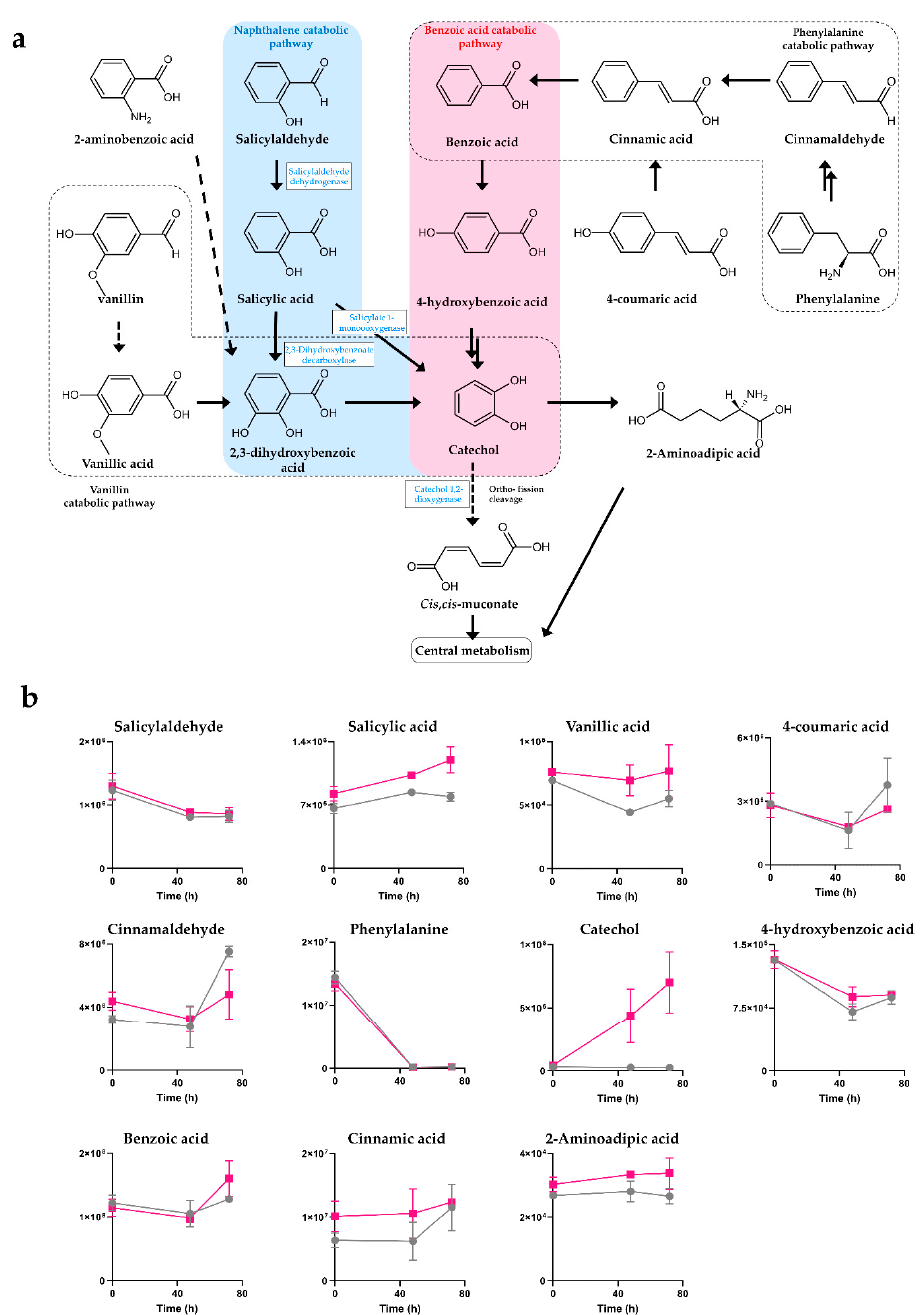
Figure 5. ( a ) Proposed degradation pathways for naphthalene-, benzoic acid-, phenylalanine- and benzene-derived compounds in Chryseobacterium sp. BSC2-3. ( b ) Graphs represent time course intracellular changes in salicylic acid, salicylaldehyde, vanillic acid, 4-coumaric acid, cinnamaldehyde, phenylalanine, catechol, 4-hydroxybenzoic acid, benzoic acid, cinnamic acid and 2-aminoadipic acid intensities in the BSC2-3 strain cultured with (pink line) and without (grey line) 20 ppm carbofuran. Chemical structures and pathways were annotated from the KEGG database. Black arrows designate a direct connection between metabolites. Dashed arrows indicate the presence of metabolites that were not